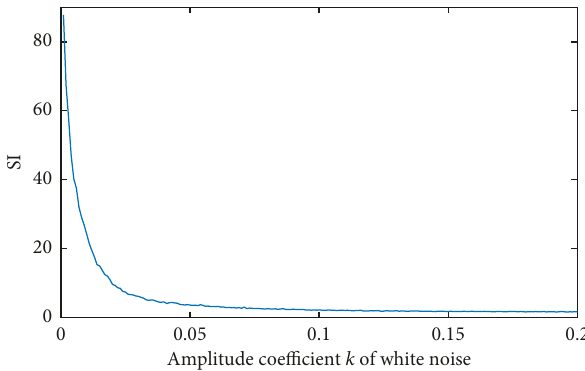
Figure 7: The extreme point distribution index SI. Figure 8. Firstly, the optimum range of white noise am- plitude is determined by the stability value of SI. In order to ensure that the amplitude of white noise can improve the distribution of signal extreme points, the minimum value of k is 0.001. The maximum value of k is set to be 0.01 so that the optimization range is not too small. In order to select the appropriate amplitude of white noise, it is necessary to determine the number of ensemble members in advance.